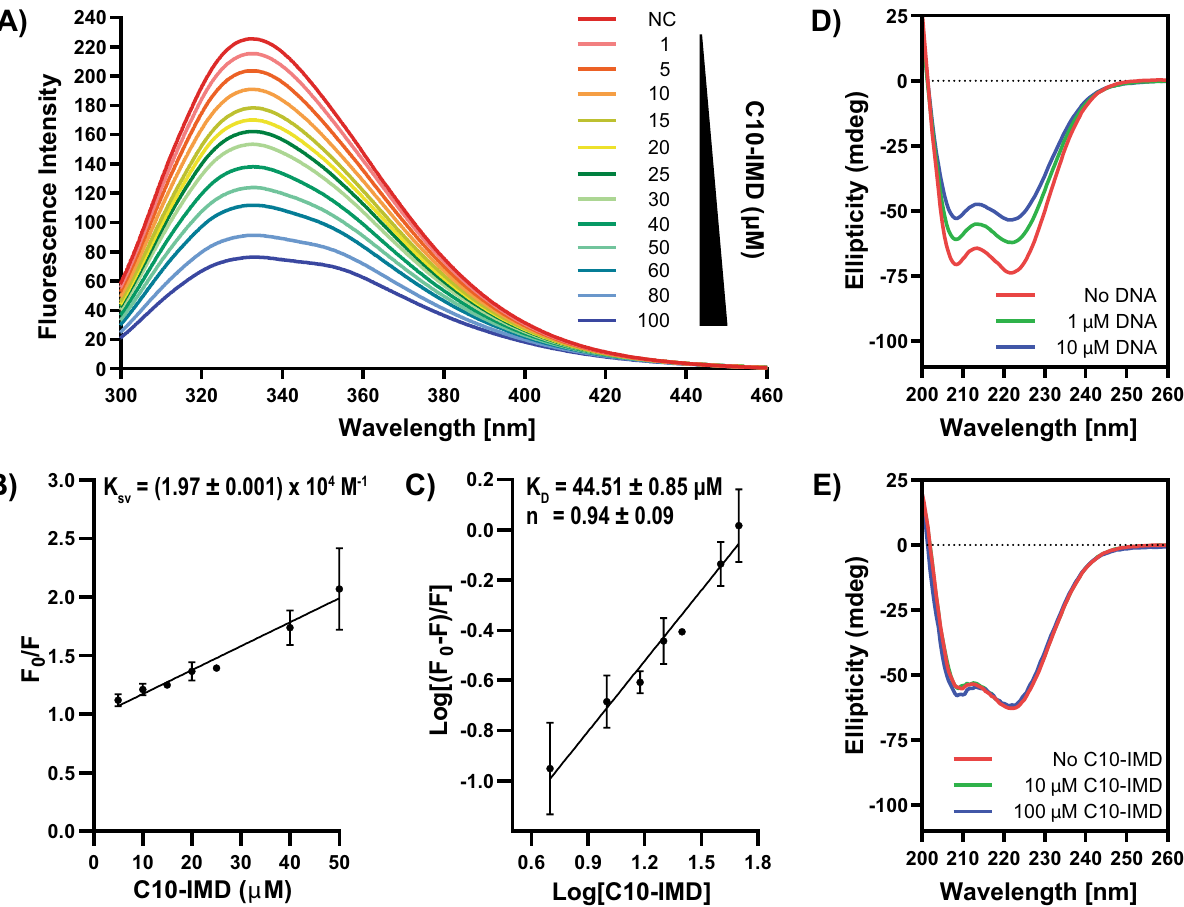
Figure 4. C10-IMD binds to a single site in Rv3160c and the interaction does not cause changes in the secondary structure of the protein. ( A ) Fluorescence quenching spectra of Rv3160c. The 10 µM Rv3160c in PBS solution is excited and quenching of fluorescence is recorded in the presence of varying concentrations of C10- IMD (1–100 μM). ( B ) Stern–Volmer plot of decrease in mean fluorescence intensity of Rv3160c in the presence of varying concentrations of C10-IMD derived from three independent experiments. The dynamic quenching rate constant K sv is evaluated from the slope of the line. ( C ) Logarithmic plot of mean relative fluorescence quenching of Rv3160c derived from three independent experiments against logarithmic concentrations of C10-IMD. K D is calculated from the intersection of the line with the y axis and the number of binding sites (n) from the slope of the line. ( D ) CD spectra of Rv3160c in the presence of 1 µM or 10 µM 86 bp rv3161c upstream fragment (DNA) (Fig. 2C). ( E ) CD spectra of Rv3160c in the presence of 10 µM or 100 µM C10-IMD. Error bars in ( B ) and ( C ) indicate standard